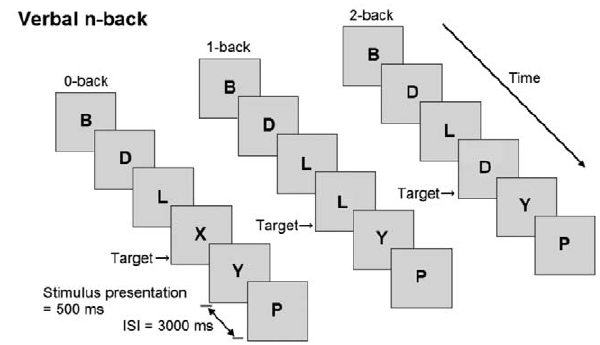
Figure 1. Schematic overview of the verbal n-back task. Stimulus presentation was 500 ms, interstimulus interval (ISI) 3000 ms. During the ISI, a fixation cross was displayed. Participants were allowed to respond until the next stimulus appeared.